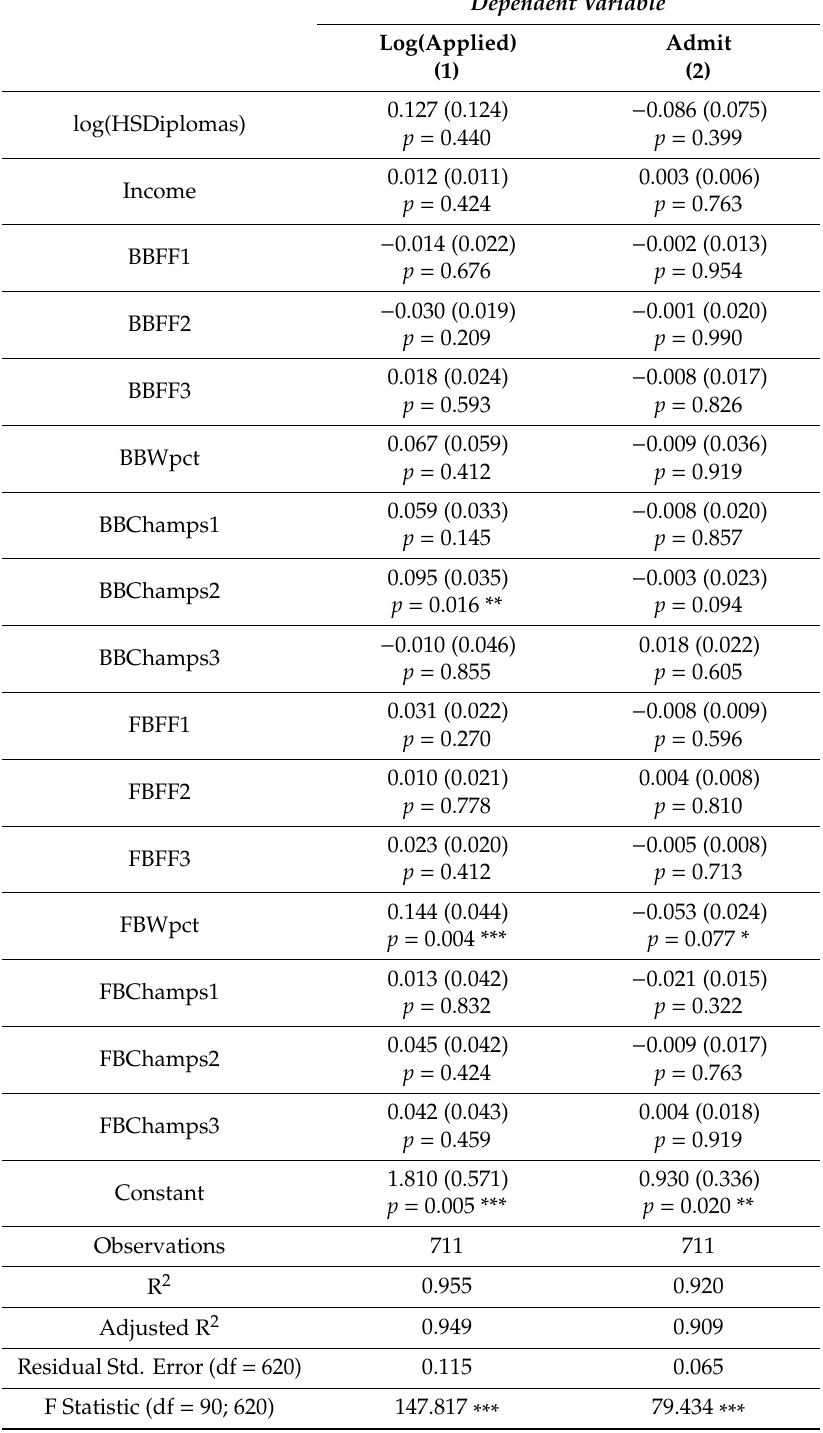
Table 3. Models for